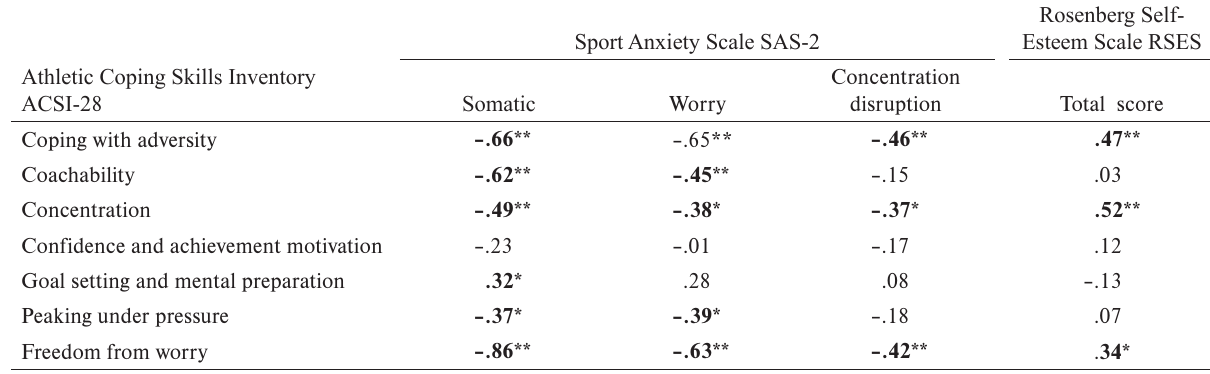
Results of correlation analysis between the Athletic Coping Skills Inventory ACSI-28, Sport Anxiety Scale SAS-2 and Rosenberg Self-Esteem Scale